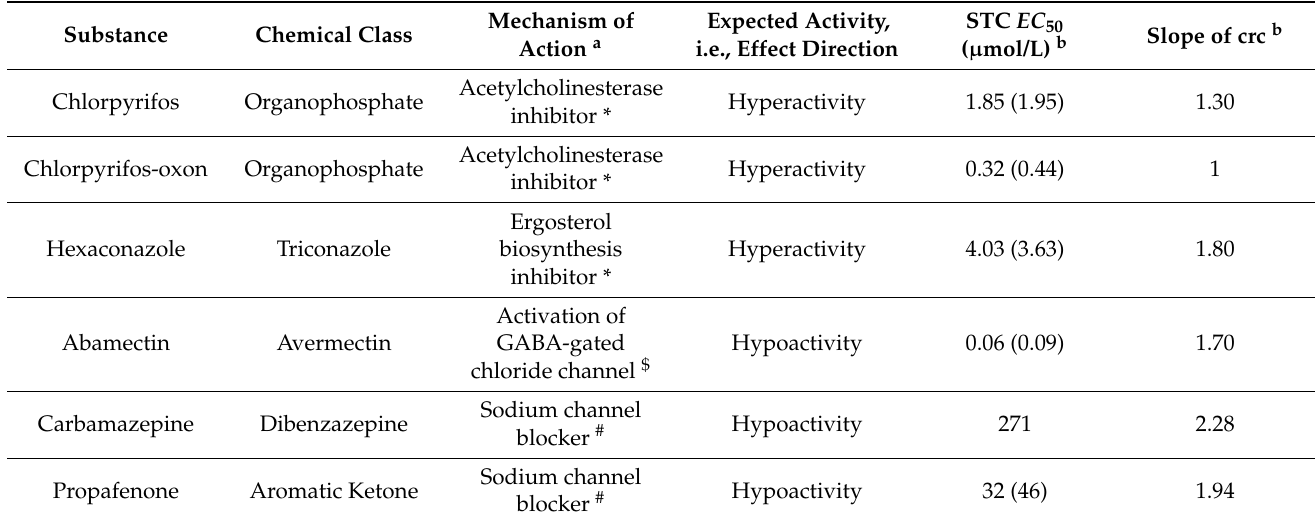
Table 1. Properties and effects of single substances in the spontaneous tail coiling (STC)